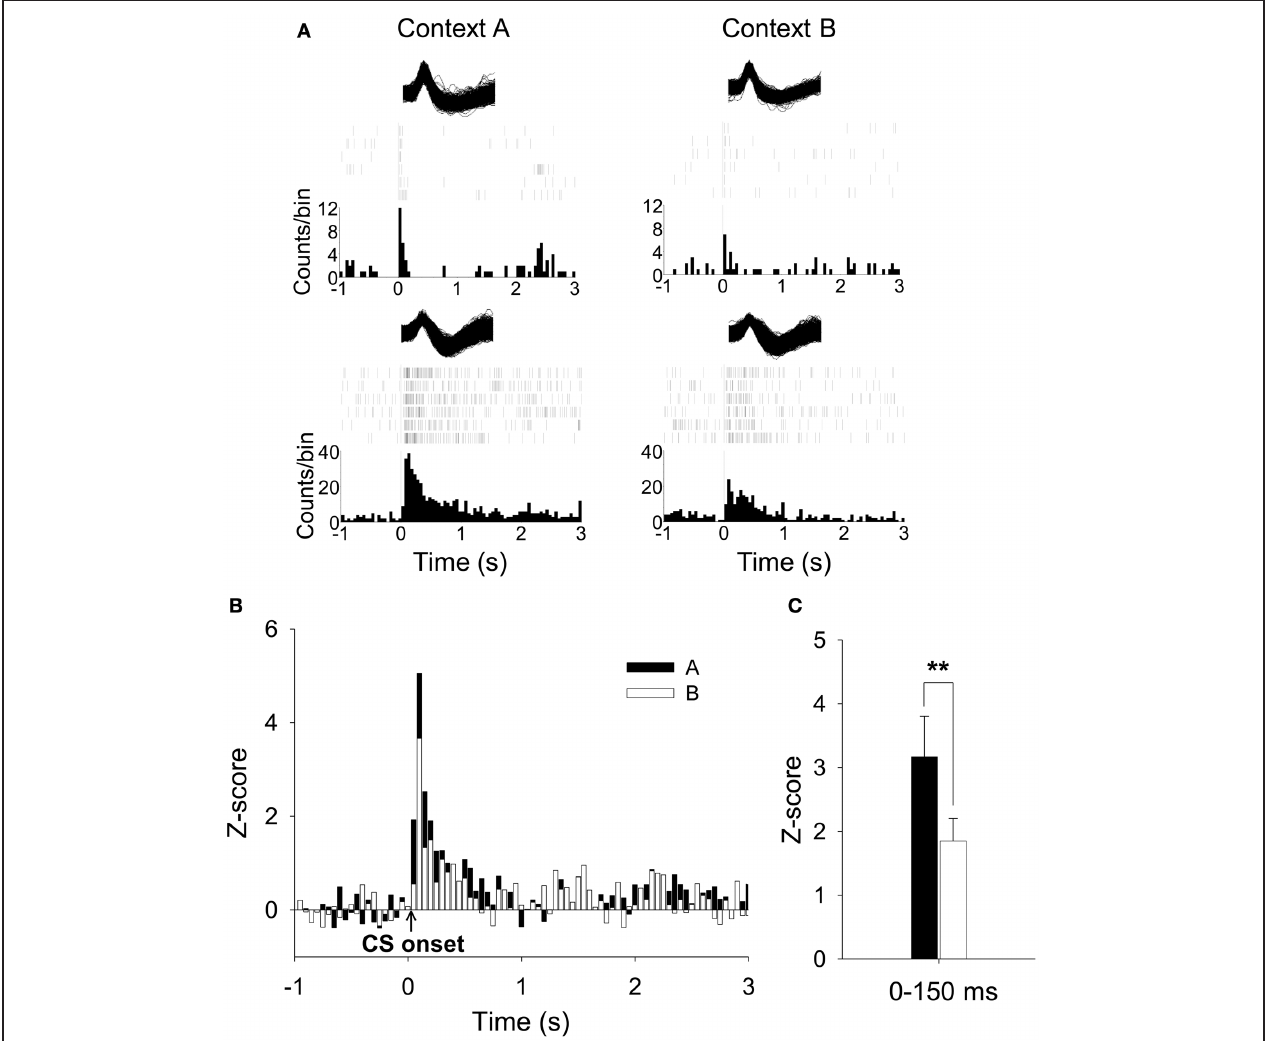
FIGURE 5 | Recorded activities of short-latency CS-responsive PL units duringCDFD. (A) Waveforms of two representative short-latency CS-responsive units, their raster plots, and the peristimulus time histograms (PSTHs) are presented. Both units showed increased firing rates to the CS in